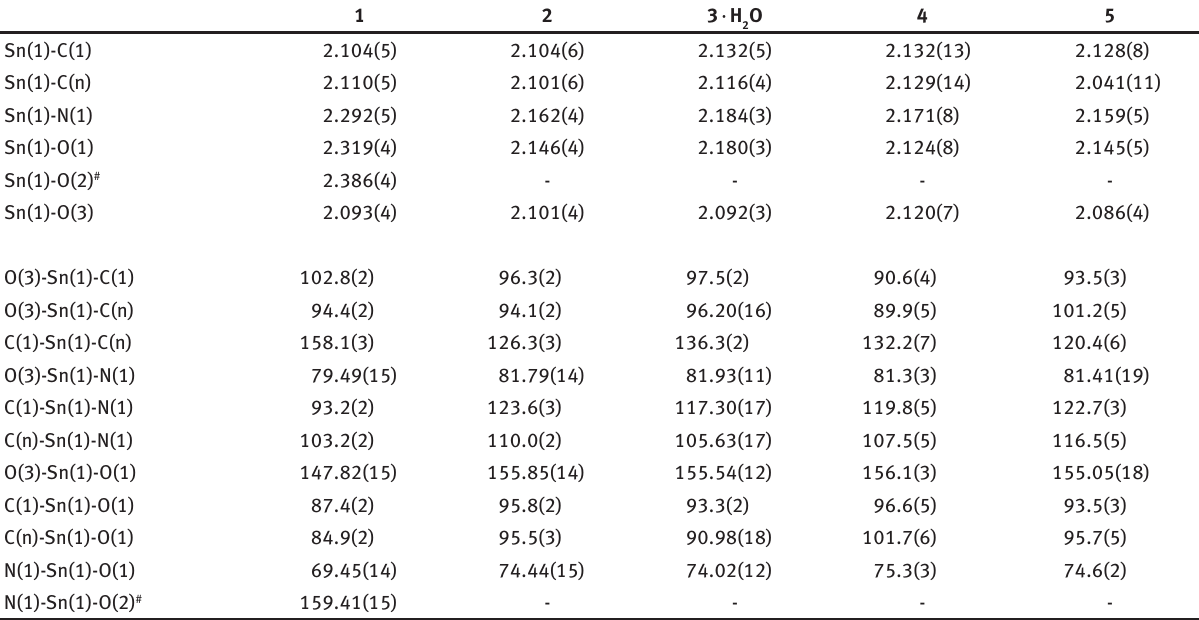
Table 1: Selected bond lengths (Å) and angles ( ° ) for the complexes*.